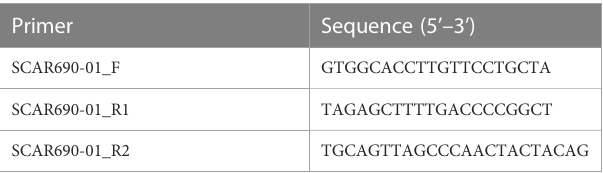
TABLE 2 Primer sequences for the SCAR marker speci fi c for CaPs gene.